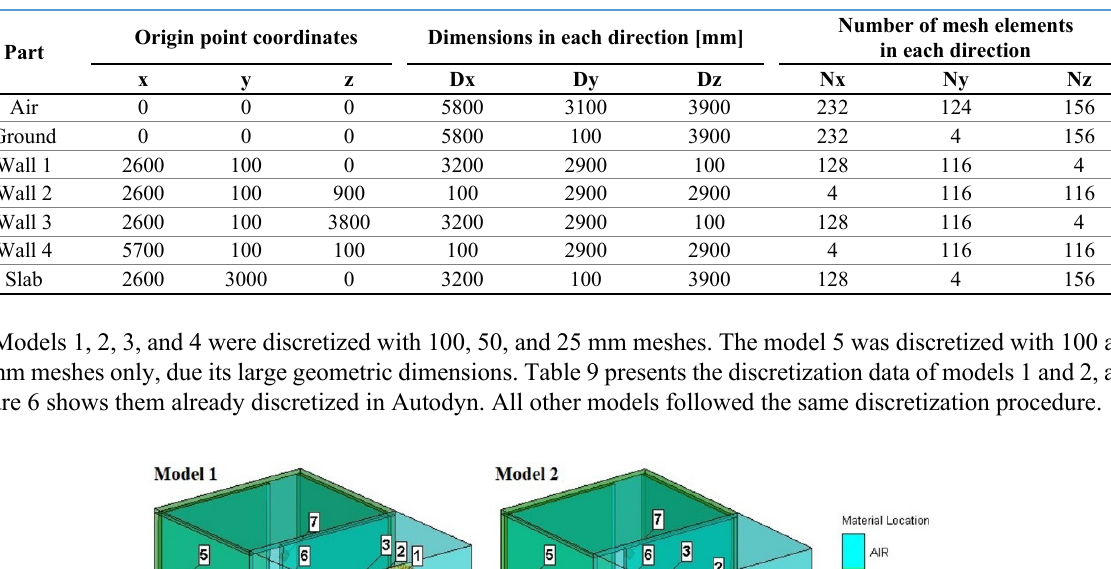
Table 9. Discretization data for models 1 and 2 with 25 mm mesh.